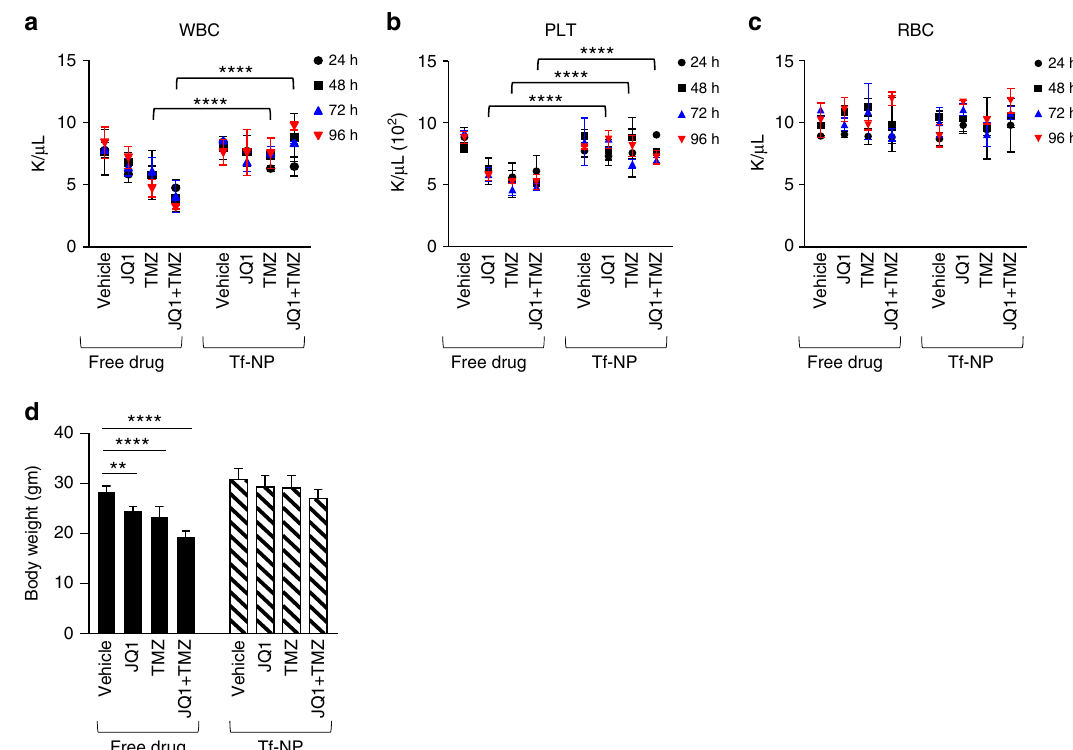
Fig. 7 Immunocompetent GL261 mice treated with drug-loaded Tf-NPs are protected from systemic drug toxicity. Mice treated with drug-loaded Tf-NPs demonstrated relative protection from a leukopenia and b thrombocytopenia caused by JQ1 and TMZ. Mice in either treatment arm did not demonstrate drops in RBC counts ( c ), which is known to be unaffected by JQ1 or TMZ. d Quanti fi cation of average daily body weights of mice at the end of the 96 h treatment course. Study powered with fi ve mice per treatment arm for statistical signi fi cance. Student t -test used to quantify changes in hematopoietic pro fi les between free drug and Tf-NP treatment arms (* p < 0.05; ** p ≤ 0.01; *** p ≤ 0.001, **** p ≤